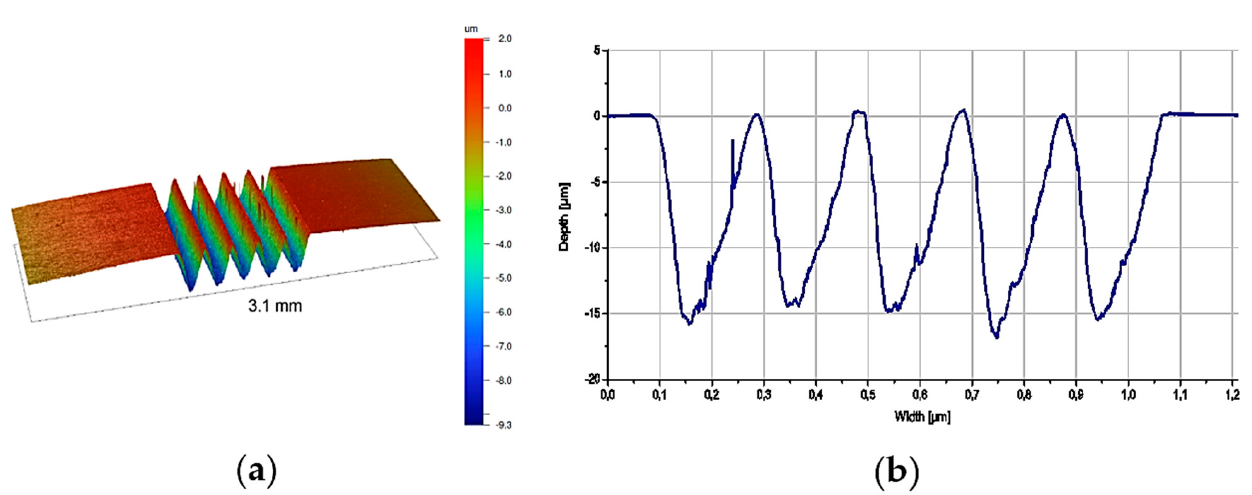
Figure 1. Images of the scaffold: ( a ) general view; ( b ) cross-section with indicated grooves geometry obtained by means of profilometer.